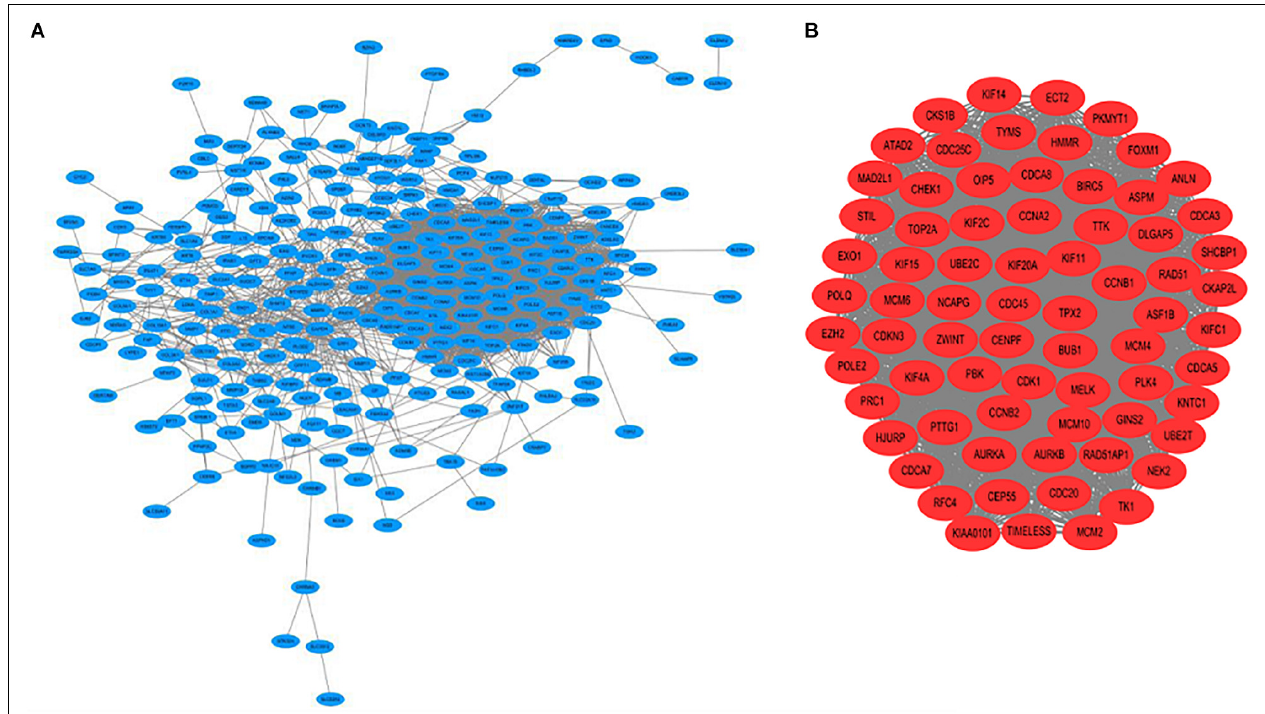
FIGURE 2 | (A) Construction of the protein–protein interaction (PPI) network. (B) Identification of the significant module.